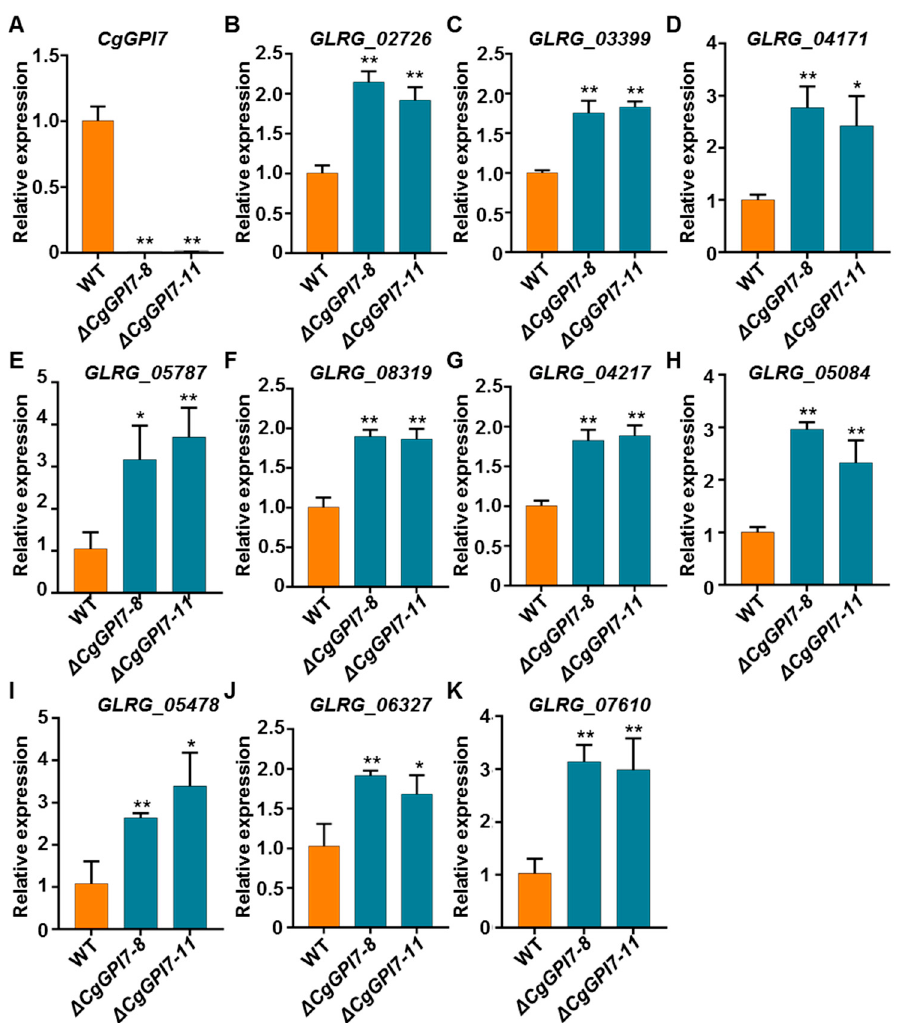
Figure 7. The expression of cell wall synthesis-related genes was induced in the ∆ CgGPI7 . ( A ) qRT- PCR was used to verify the expression of CgGPI7 in wild-type, ∆ CgGPI7-8, and ∆ CgGPI7-11 strains. ( B – F ) Expression of five chitin synthase genes were quantified in wild-type, ∆ CgGPI7-8, and ∆ CgGPI7-11 strains via qRT-PCR. ( G – K ) Expression of five 1,3-beta-glucanosyltransferase genes were quantified in wild-type, ∆ CgGPI7-8, and ∆ CgGPI7-11 strains via qRT-PCR. Significance analysis was analyzed using Student’s t -test (* p < 0.05, ** p < 0.01). The bar represents the standard deviation of the three technical duplications.